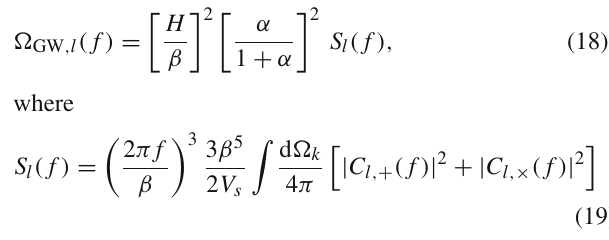
bubble nucleated within time t n < t < t n + d t n in a